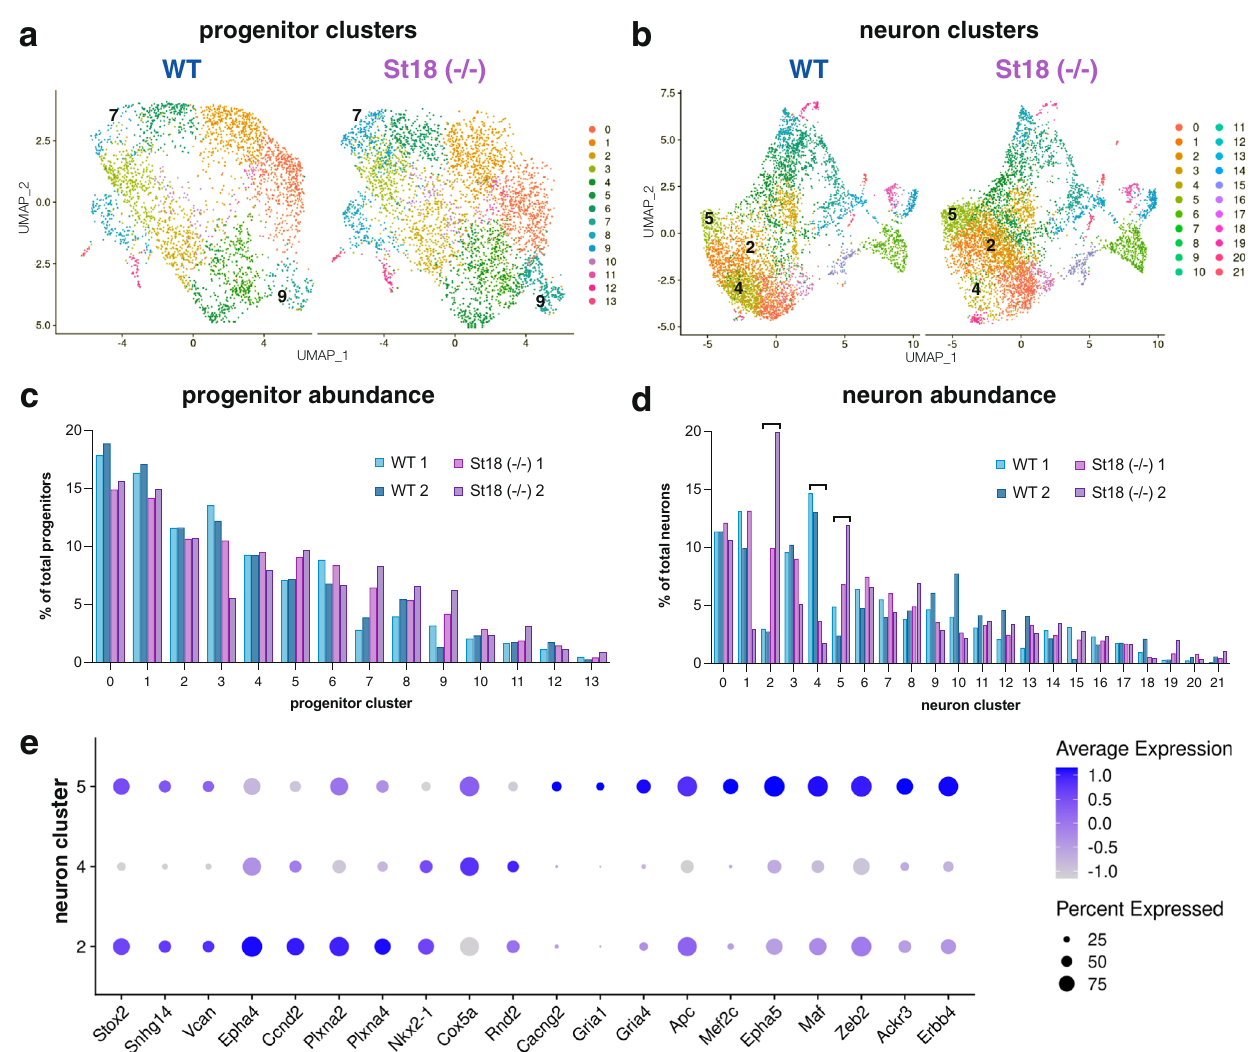
Fig. 6 | Single-cell RNA-seq reveals that speci fi c neuronal clusters are differ- entially produced upon St18 genetic ablation. a UMAP visualization of 14 pro- genitor clusters identi fi ed in WT (left) and St18 ( − / − ) ( St18 ( − / − ), right) e14.5 MGE. b UMAP visualization of 22 neuronal clusters identi fi ed in WT (left) and St18 ( − / − ) e14.5 MGE. Relative proportions of each c progenitor cluster and d neuronal clus- ters,biologicalreplicatesplottedseparately.WTreplicates1and2inshadesofblue,